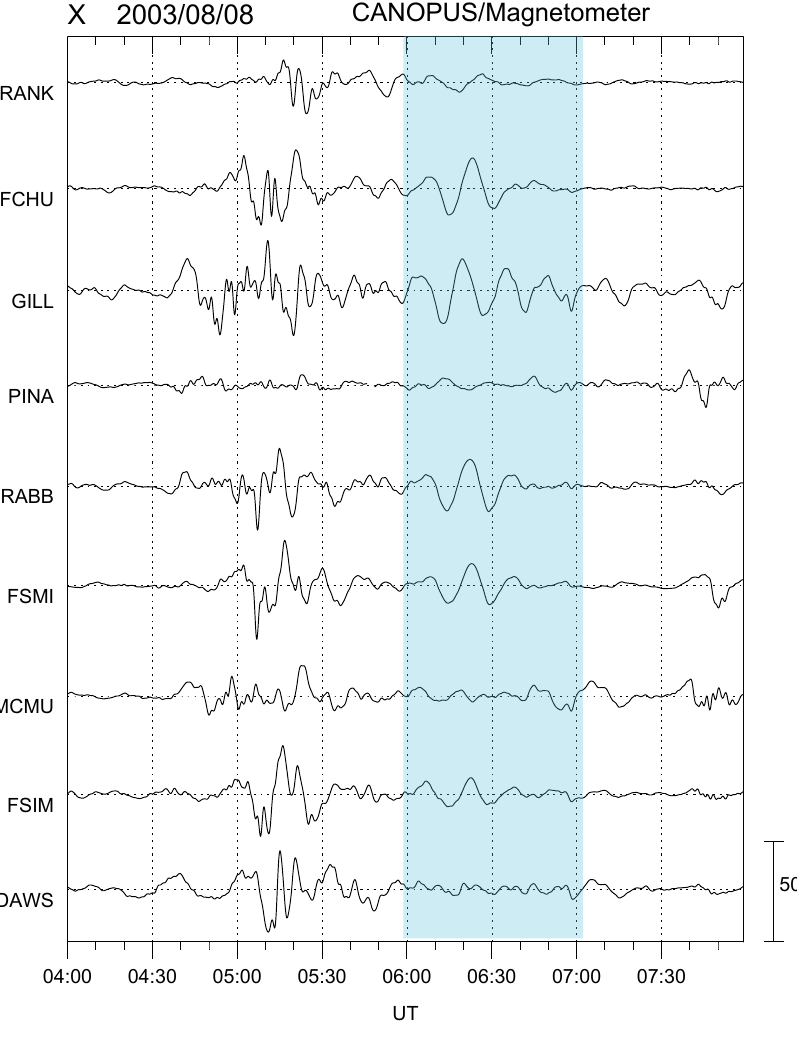
Figure 5 Fig. 5. The band-pass (with cut-off periods of 100–2000s) filtered data in the X (geographic north) component from the CANOPUS chains